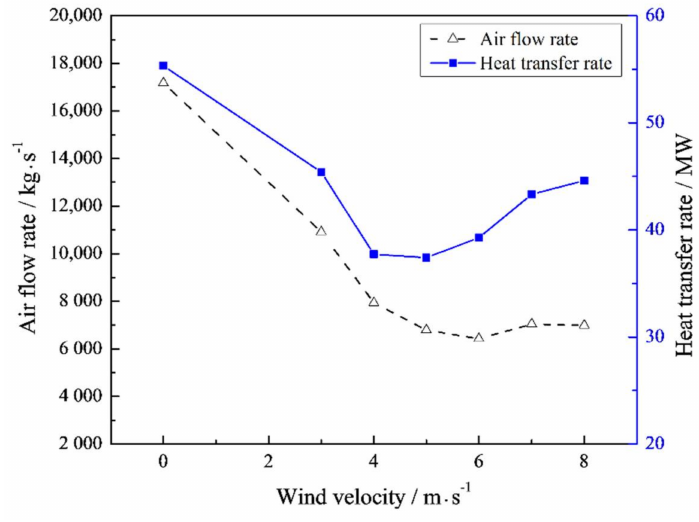
Figure 13. Air flow rate and heat transfer rate versus wind velocity.